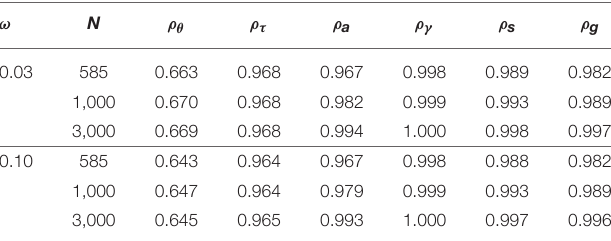
TABLE 7 | Correlations between true and estimated latent learning ability ( θ ) and initial speed ( τ ) of learners, item response time model parameters ( a , γ ), and DINA model item parameters ( s , g